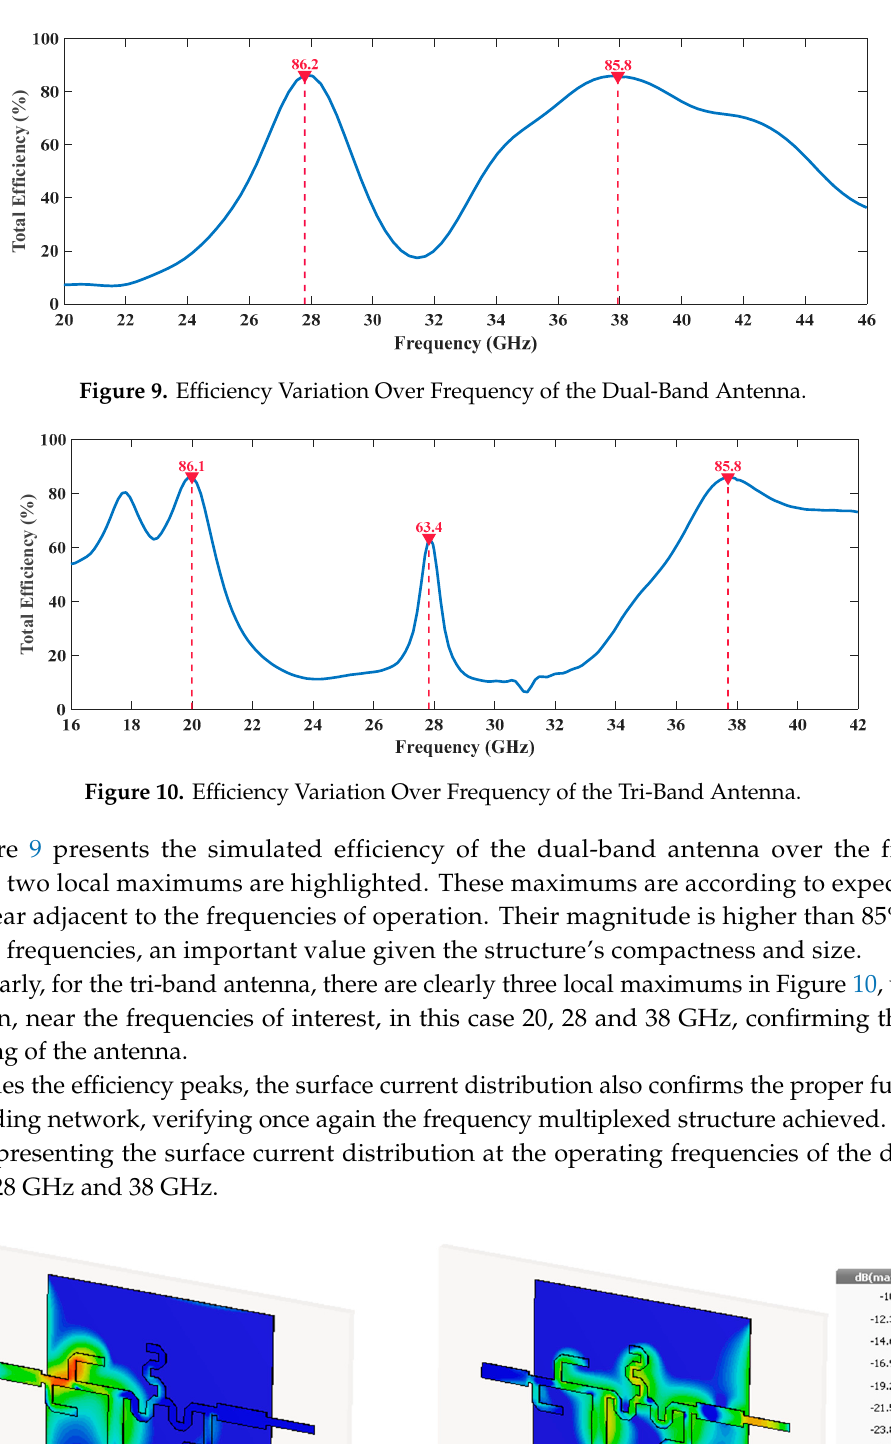
( c ) Figure 12. Surface Current Distribution at ( a ) 20 GHz, ( b ) 28 GHz and ( c ) 38 GHz. Once again at each one of the resonant frequencies, only the respective monopole has any current through it, all the others remain not fed. With this, it is possible to state that the frequency multiplexing concept proposed allowed to isolate, in frequency, each radiating element, maintaining a single input feed and without requiring any additional filters. Figure 13 and Figure 14 show the gain variation of both prototypes over frequency, highlighting the respective values at the operating frequencies. It is possible to verify that, in the tri-band case, the gain values vary between 2.5 dBi and 4.5 dBi, in the frequencies of interest and they are mainly dependent on the antenna structure. Figure 13. Gain Variation Over Frequency of the Dual-Band Antenna.